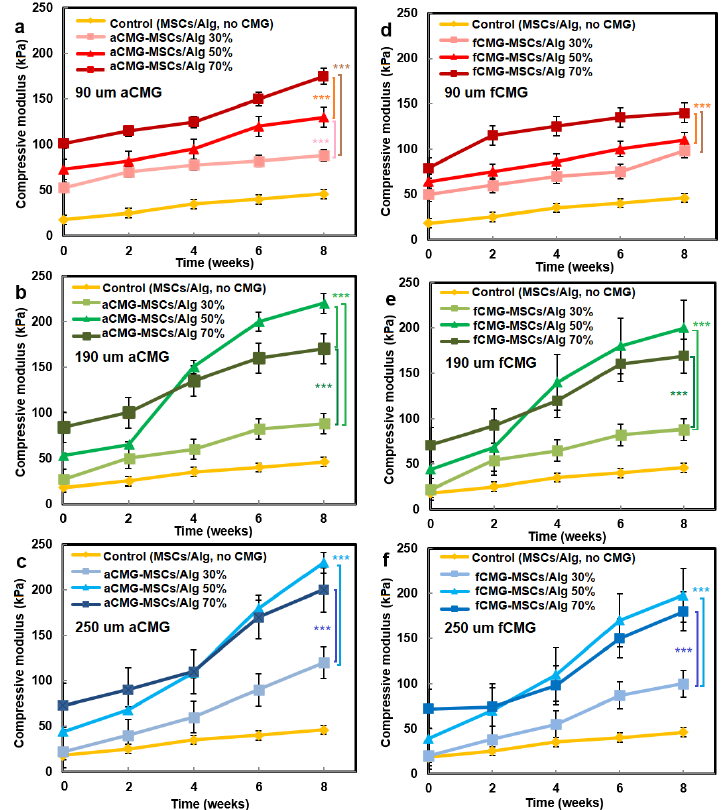
Figure 7. The compressive modulus of aCMG-MSCs/Alg (left column) and fCMG-MSCs/Alg (right column) hydrogels with culture time in chondrogenic medium as a function of CMG loading and average CMG size; CMG loadings were 30% (light shade), 50% (medium shade), and 70% (dark shade). The average CMG sizes in ( a , d ), ( b , e ), and ( c , f ) were 90 ( a ), 190 ( b ), and 250 μm ( c ), respec- tively; the control group (yellow) was MSCs (without CMGs) encapsulated in the alginate hydrogel and cultured in chondrogenic medium; three asterisks (***) indicate a statistically significant dif- ference between two experimental groups at a given time point at the level of p < 0.001.